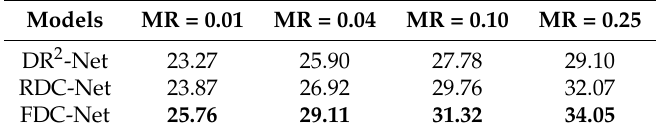
Table 4. The PSNR value of different networks on ImageNet Val dataset.